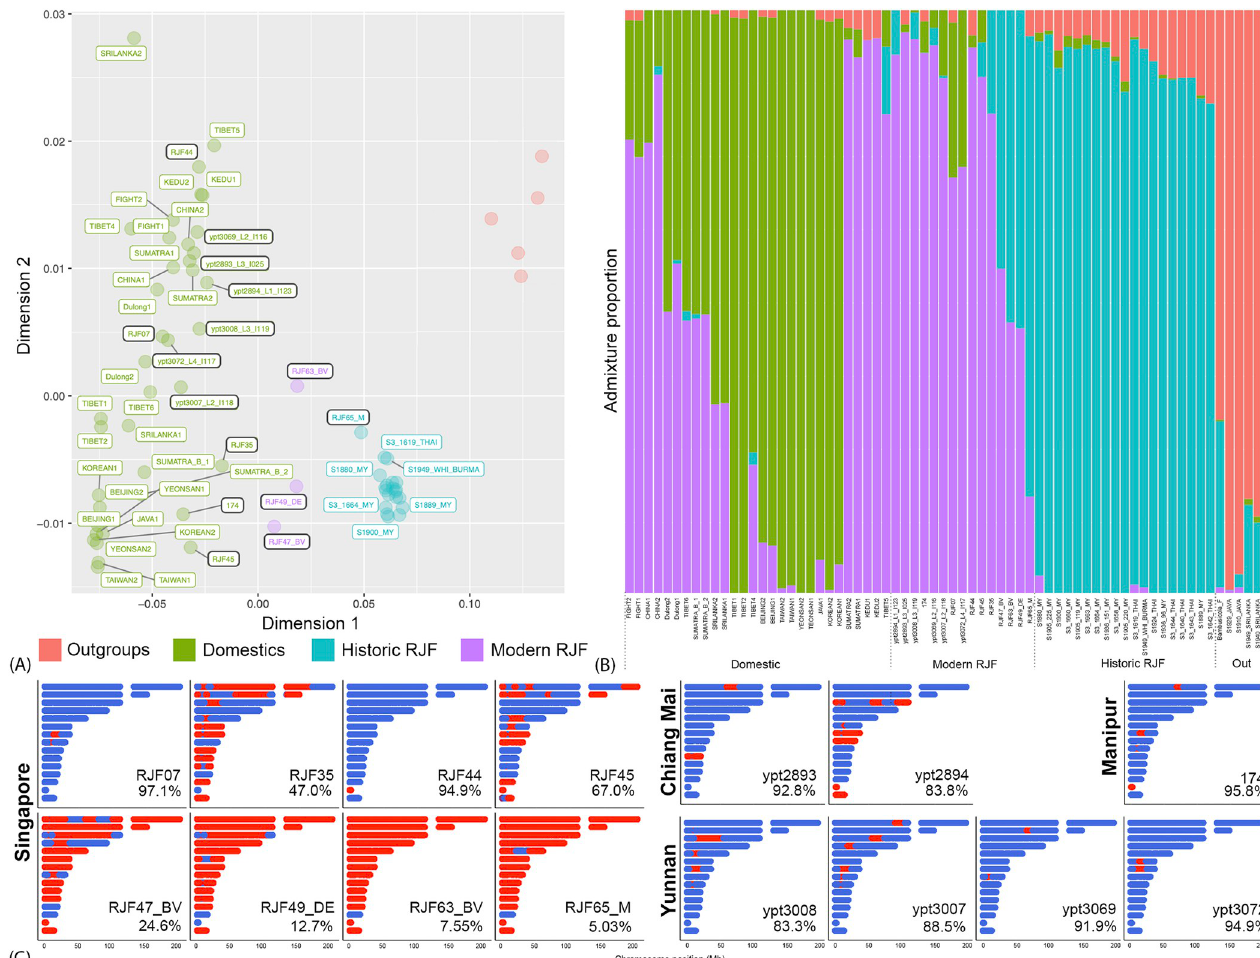
Fig 2. Ancestry inference of 15 representative modern red junglefowl from four localities across the range of Gallus gallus spadiceus . (A) Multi- Dimensional Scaling plot from Struct-f4 ( K = 4) assuming no admixture based on 2,603,726 SNPs. Modern red junglefowl samples are highlighted with a black frame; historic red junglefowl samples are to the right of the modern ones (teal), and domestic chicken samples to the left (green). The color legend indicates which population each sample is assigned to regardless of actual identity (RJF = red junglefowl). (B) Individual ancestry profiles from Struct-f4 ( K = 4) based on 2,603,726 SNPs. Colors refer to genomic contributions as inferred in 2A. ‘Out’ refers to the outgroups used in the analysis. (C) Local ancestry inference based on 143,526 SNPs using Efficient inference of local ancestry (EILA). Only the top 15 chromosomes (Chr 1, 2, 3, 4, 5, 6, 7, 8, 9, 10, 12, 13, 14, 16, 20) with the most SNPs called are illustrated. Blue coloration refers to domestic ancestry and red coloration refers to wild ancestry. The percentage of genome-wide SNPs with domestic ancestry is given on the bottom right.